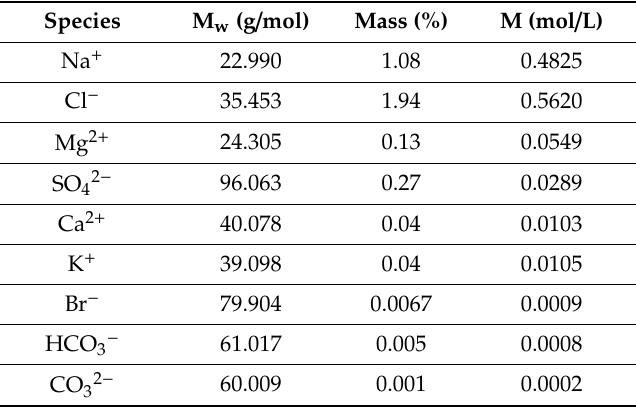
Table 2. Typical composition of Atlantic sea